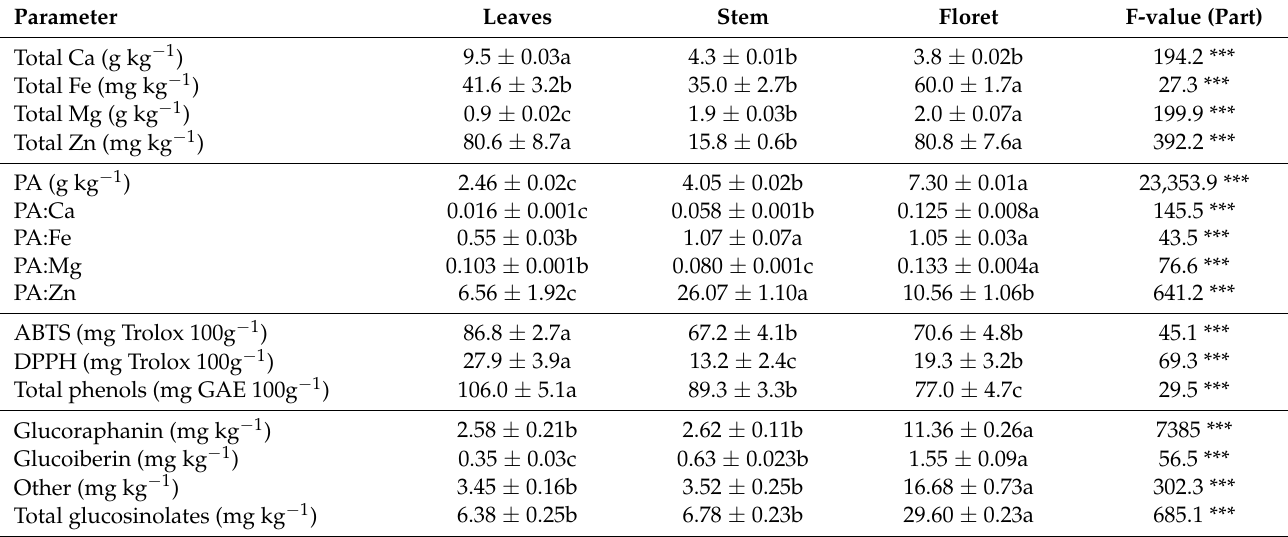
Table 2. Total broccoli Ca, Fe, Mg, Zn, phytic acid (PA), PA:mineral molar ratios, ABTS, DPPH, total phenols, glucoraphanin, glucoiberin, other glucosides and total glucosinolates under the different broccoli fractions (mean ± standard error of the mean; F-values derived following a one-way analysis of variance for the broccoli fraction). Parameter